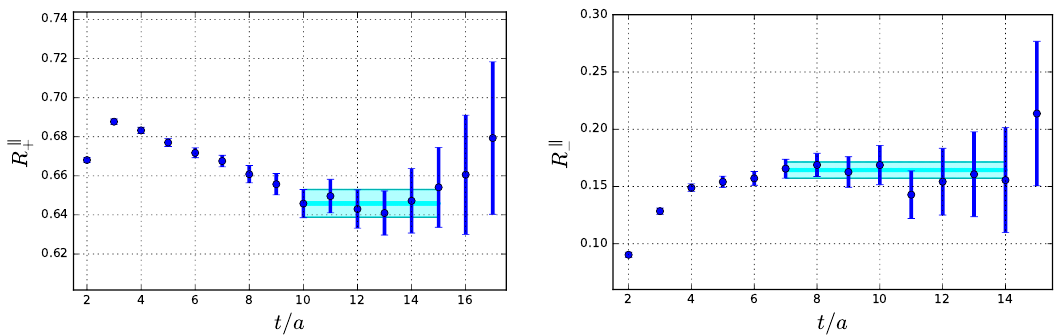
Figure 1 . The data points in these plots show R averaged correlation functions according to eq. (3.9) on the (cid:12) = 5 : 29, (cid:20) = 0 : 13632, L = 32 a , T = 64 a ensemble. The cyan-colored bar indicates the (cid:12)tted value of R